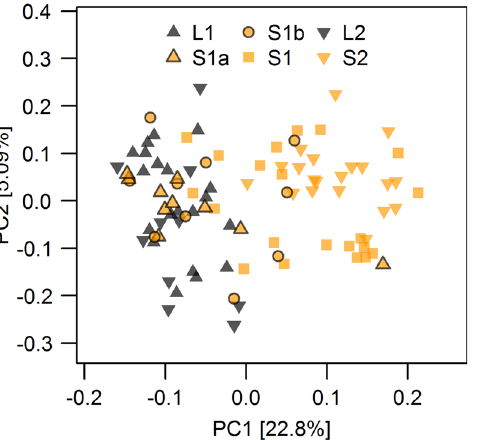
Fig 7. Principal component analysis of parallel lake-stream differentiation SNPs. PC1 separates migratory lake and resident stream ecotypes based on the SNPs found in parallel genomic islands of lake- stream differentiation shown in Figs 4B and 5(n = 75). Individuals with both lake-like and stream-like genomic signatures occur at stream sites S1a, S1b and S1, but lake ecotypes dominated at sites S1a and S1b, while stream ecotypes were most common at S1. Only stream ecotypes occurred at site S2 and only lake ecotypes at sites L1 and L2. Fill colors indicate the habitat in which individuals were caught, four stream habitat sites (orange) and two lake shore sites